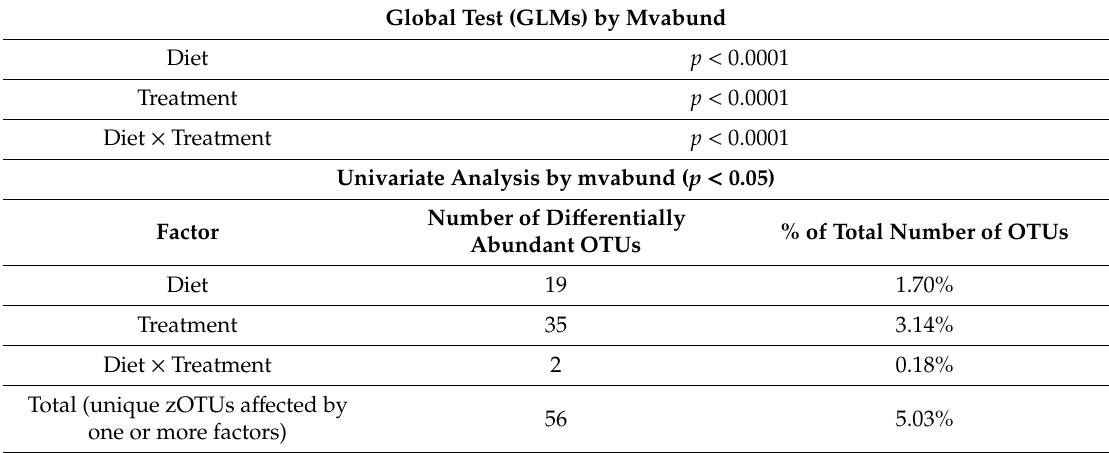
Table 3. Summary of statistical tests on di ff erential zOTU